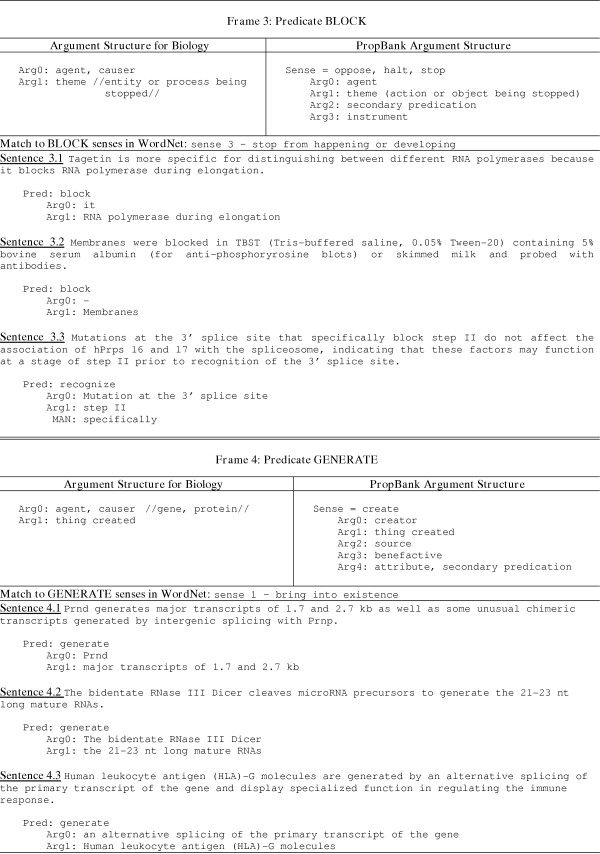
Examples of predicate-argument structures for group B Predicate-argument structure for block, belonging to group B – same sense, fewer arguments, is shown as Frame 3. Though block is used to mean stop in both biological corpus and business news corpus, set of arguments are not the same. Use of MAN is illustrated here. Similar to predicate block, PASBio's predicate-argument structure of generate has less arguments than in PropBank [22, 23] as shown in Frame 4.